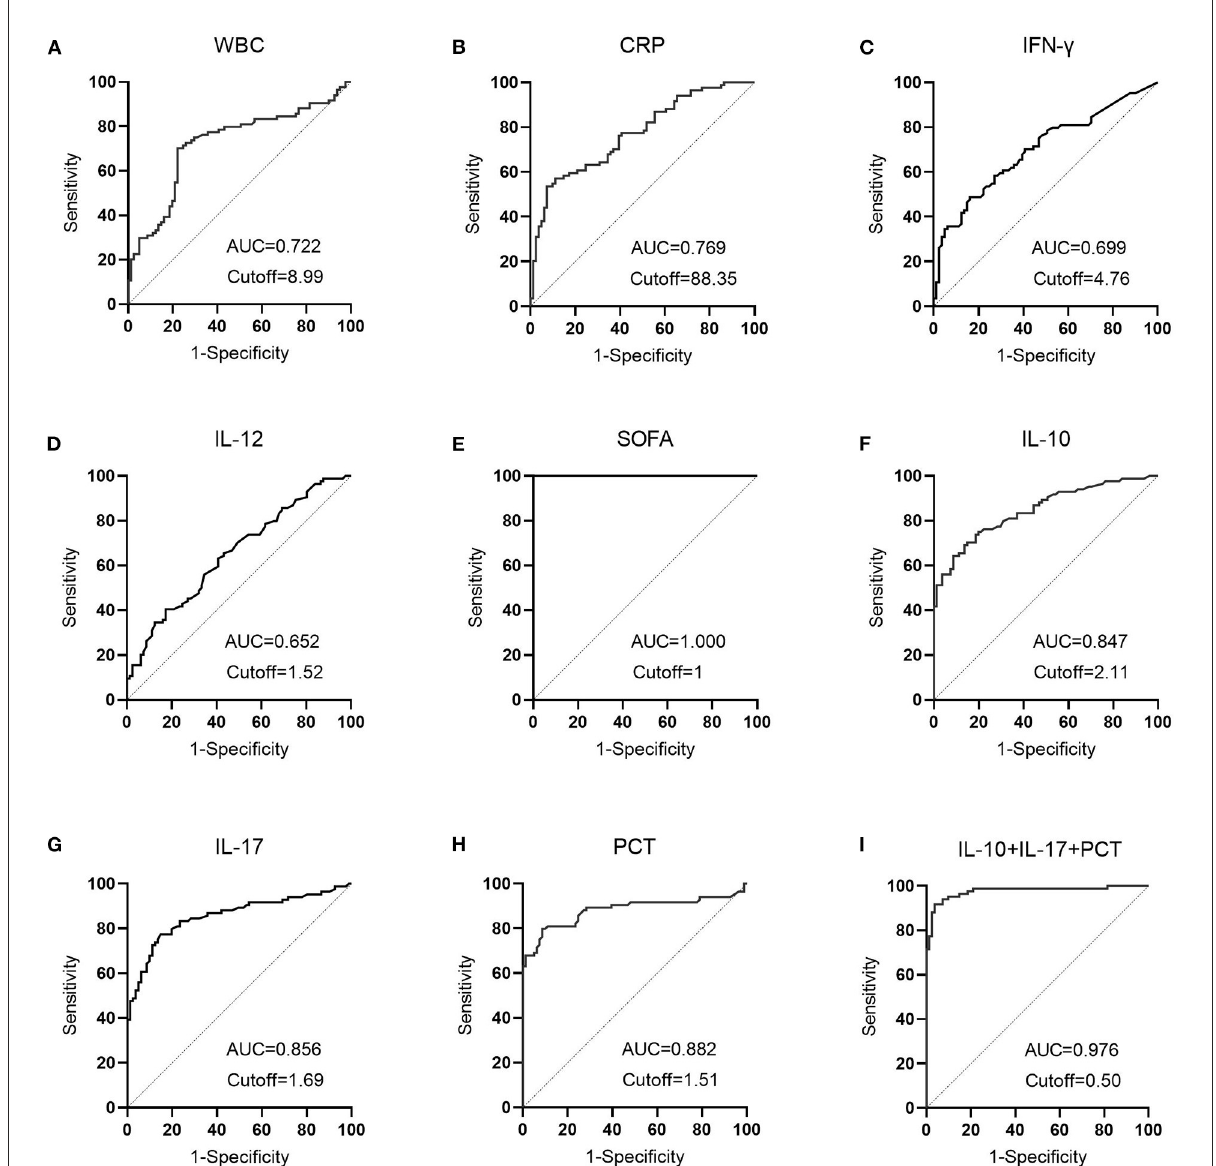
FIGURE6 The diagnostic performance of LASSO regression analysis variables in patients with sepsis vs. infection. (A) The diagnostic performance of WBC in patients in the sepsis and infection group; (B) The diagnostic performance of CRP in patients in the sepsis and infection group; (C) The diagnostic performance of IFN- γ in patients in the sepsis and infection group; (D) The diagnostic performance of IL-12 in patients in the sepsis and infection group; (E) The diagnostic performance of SOFA in patients in the sepsis and infection group; (F) The diagnostic performance of IL-10 in patients in the sepsis and infection group; (G) The diagnostic performance of IL-17 in patients in the sepsis and infection group; (H) The diagnostic performance of PCT in patients in the sepsis and infection group; (I) The diagnostic performance of IL-10 + IL-17 + PCT in patients in the sepsis and infection